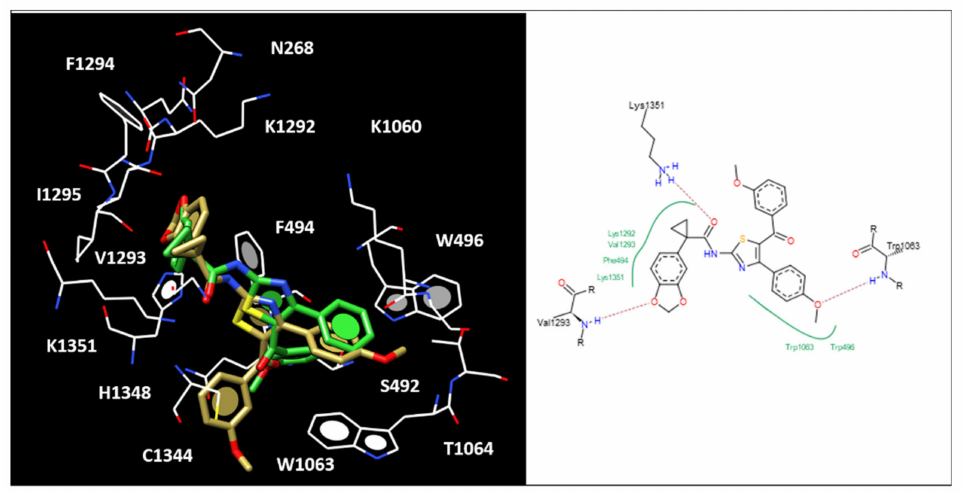
Figure 10. Docking positioning at the modelled F508del-CFTR of 7q (C atom; light green) and 9h (C atom; gold). The hybrid 9h ligplot is shown on the right.